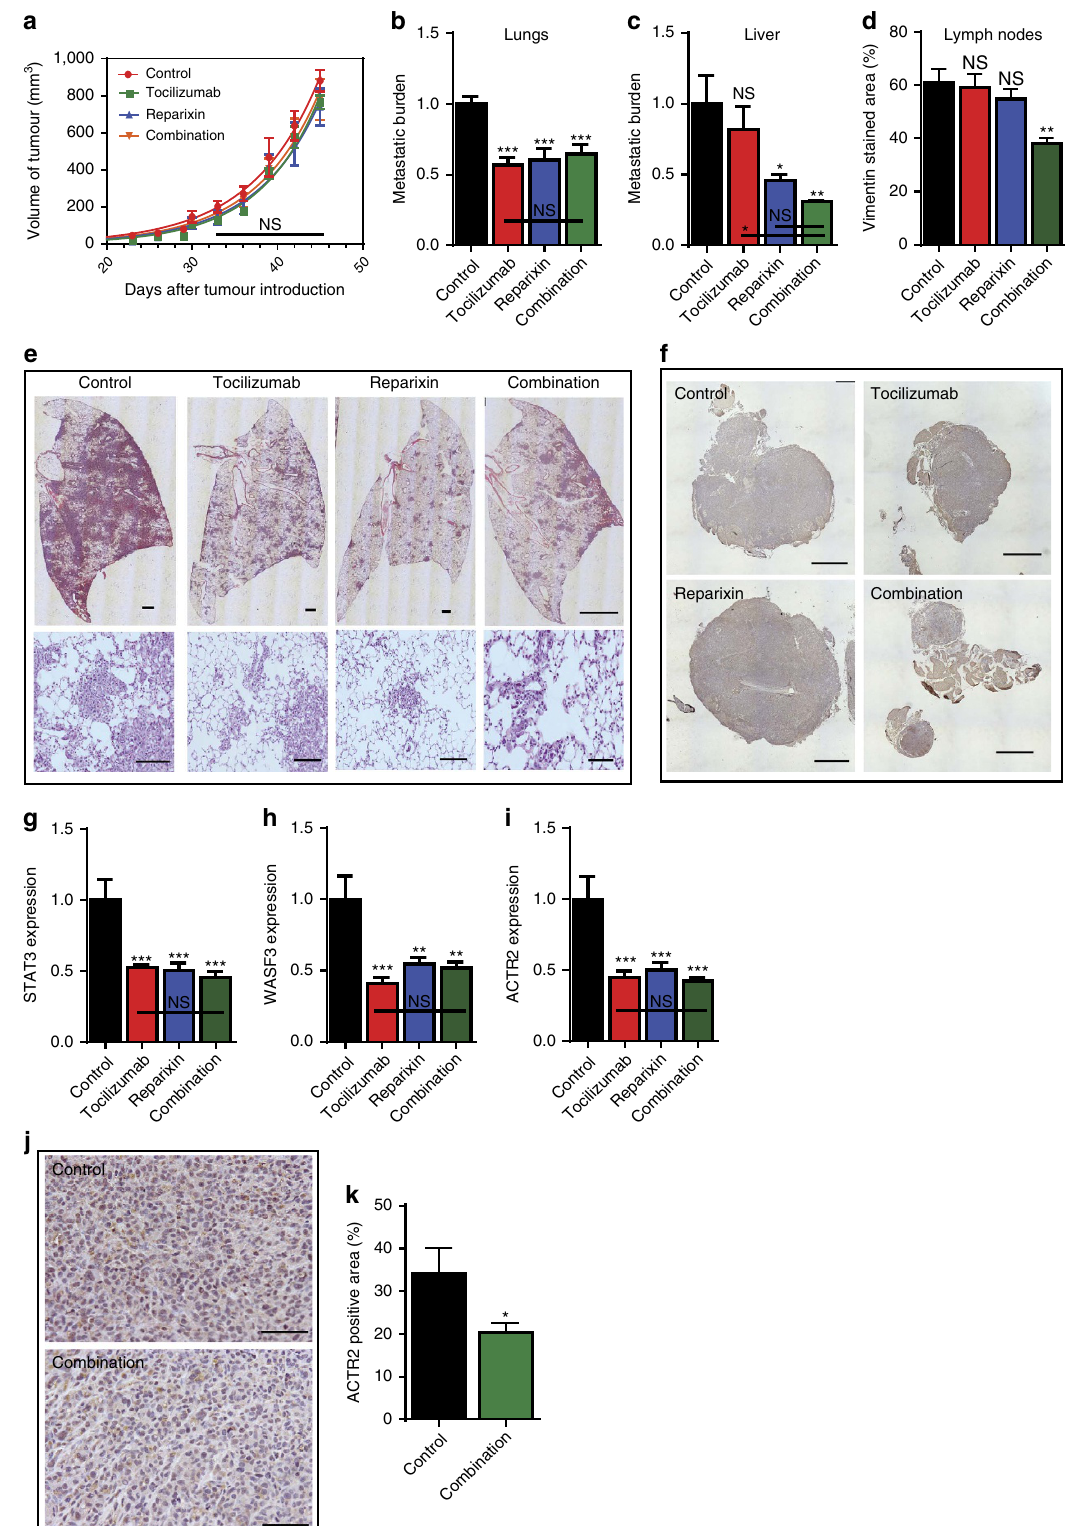
Figure 5 | In vivo validation. ( a ) Tumour volume measured over time. ( b , c ) Human genomic DNA content in mouse lungs and livers were quantified using qPCR to determine the metastatic burden. ( d ) Vimentin staining of lymph nodes quantified by image analysis. ( e ) Images of mice lungs that were stained with hematoxylin and eosin. Scale bar, 100 m m. ( f ) Images of lymph nodes that were stained with vimentin. Scale bar, 100 m m. ( g – i ) Decreased expression of STAT3, WASF3 and Arp2/3 in treated group compared with the control group. ( j ) Immunohistochemical staining of primary tumour sections for Arp2/3. Scale bar, 100 m m. ( k ) Arp 2/3 staining of primary tumour sections quantified by image analysis. In all panels, data is represented as mean ± s.e.m. of five mice. * P o 0.05; ** P o 0.01; *** P o 0.001 (ANOVA). NATURE COMMUNICATIONS|8:15584|DOI: